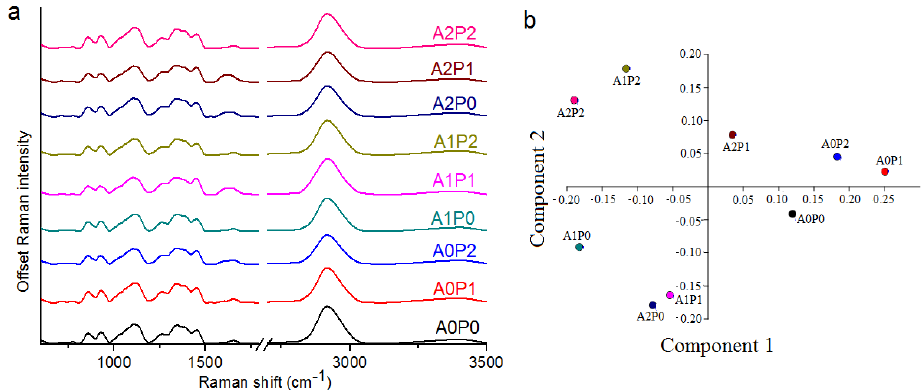
Figure 12. ( a ) FT-Raman spectra of oat grains (2016); ( b ) PCA analysis of FT-Raman spectra of oat grains in 800–1800 cm − 1 where A0P0—no fertilizer, no magnetostimulation; A0P1—no fertilizer, short magnetostimulation; A0P2—no fertilizer, longer magnetostimulation; A1P0—average dose of algae, no magnetostimulation; A1P1—average dose of algae, short magnetostimulation; A1P2—average dose of algae, longer magnetostimulation; A2P0—maximum dose of algae, no magnetostimulation; A2P1—maximum dose of algae fertilizer, short magnetostimulation; A2P2—medium dose of algae, longer magnetostimulation.